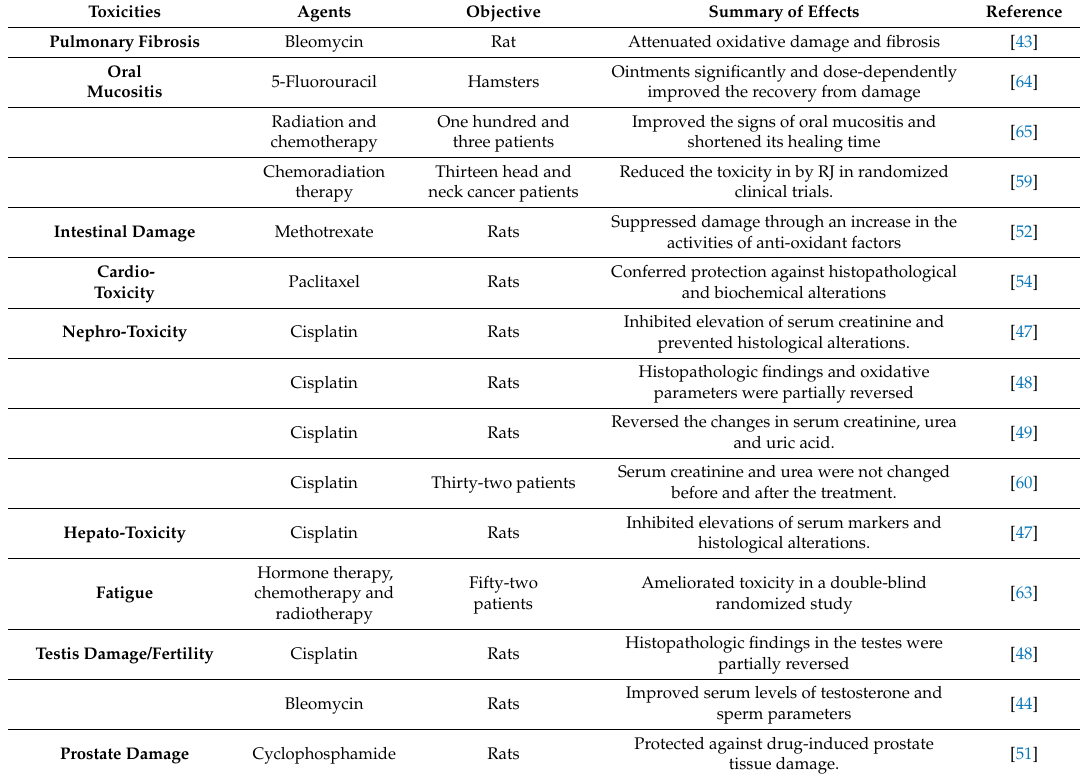
Table 1. Effects of royal jelly on anti-cancer agent-induced